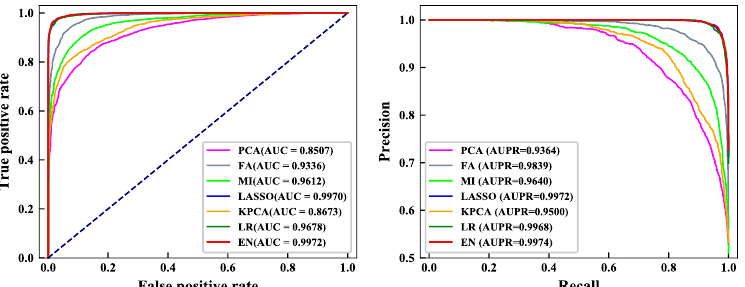
Figure 2. Comparison of receiver operating characteristic (ROC) and precision recall (PR) curves of seven dimensionality reduction methods. ( left ) ROC curve of the seven dimensionality reduction methods; ( right ) PR curve of the seven dimensionality reduction methods.